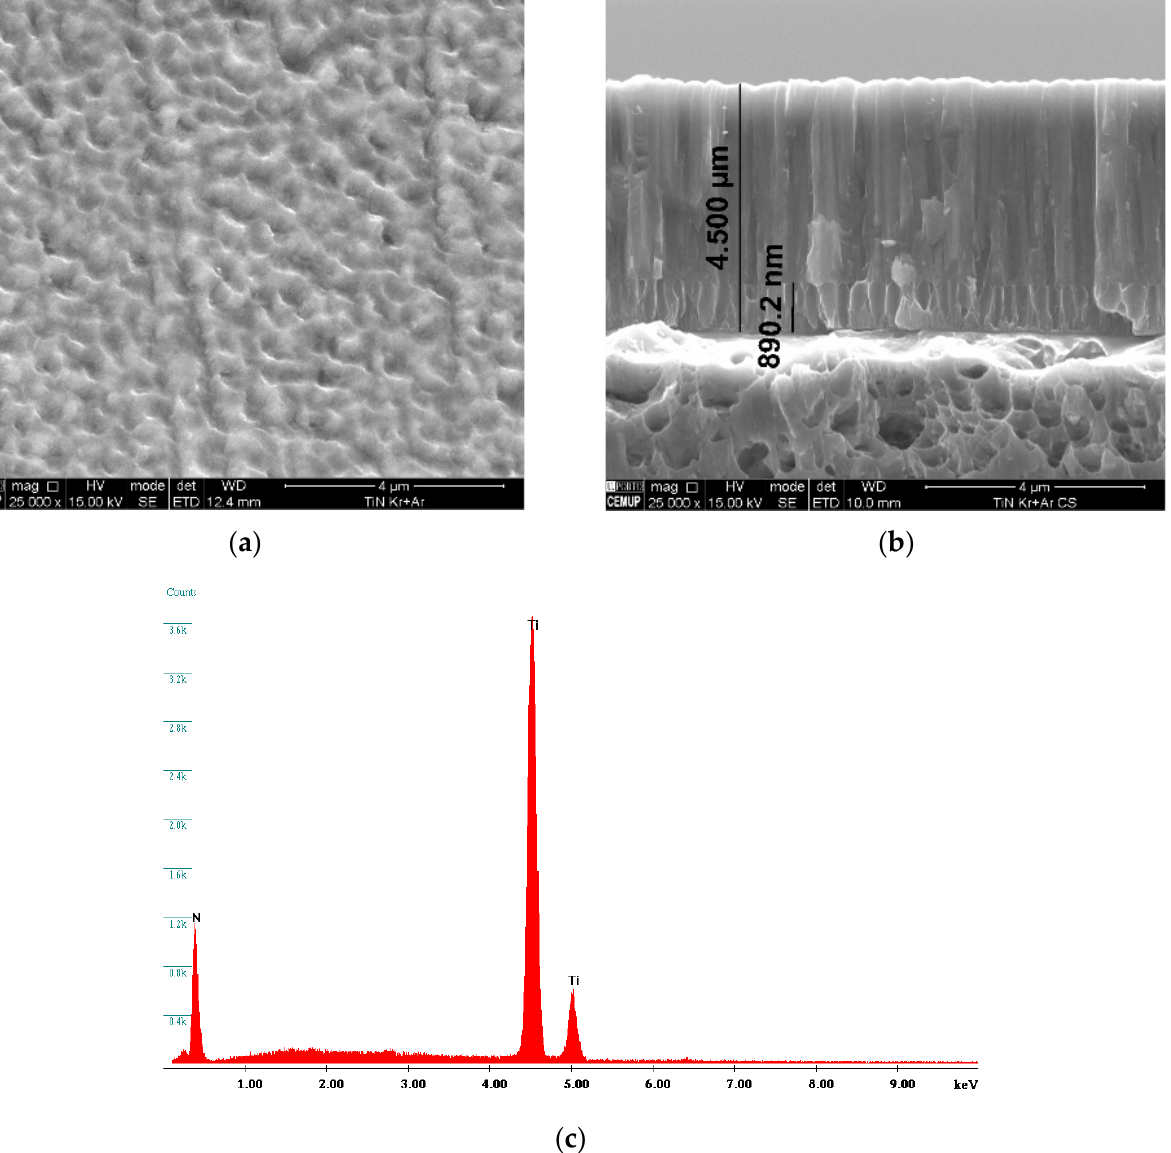
Figure 3. Morphological characterization of the film: ( a ) surface, ( b ) cross-section, ( c ) EDS spectra.